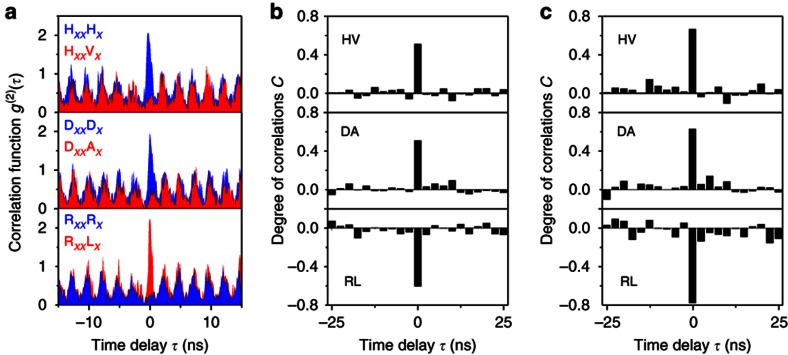
Figure 5 | Polarization correlation results from the ST-ELED under electrically pulsed injection at repetition rate of 400 MHz. (a) Normalized correlation functions for co- and cross-polarized XX and X photons in HV, DA and RL bases. (b,c) Degree of correlation C in given basis, in which correlation in HV and DA bases (C>0) and anti-correlation (C<0) in RL basis are obtained without temporal gate (Δτ=2.5 ns) and with a temporal gate width Δτ=0.8 ns centred at 0 delay time, respectively.